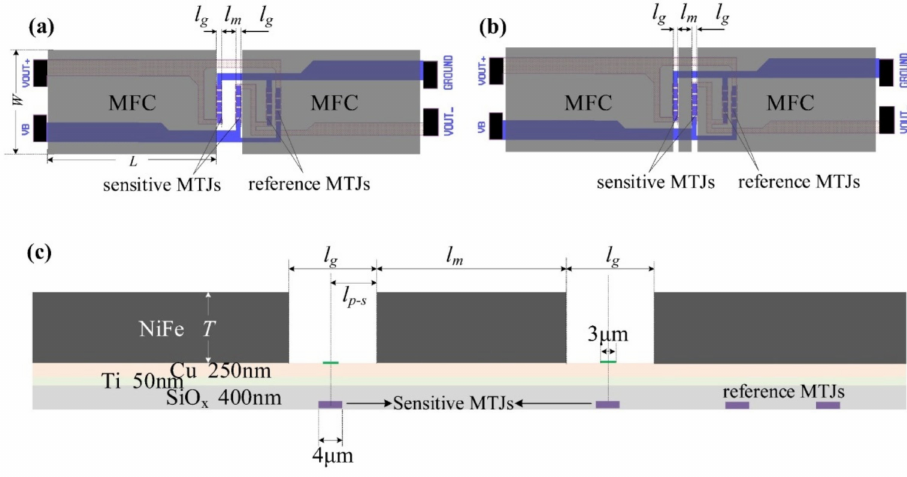
Figure 1. Layout of the sensor containing ( a ) single-gap magnetic flux concentrators (MFCs), ( b ) double-gap MFCs, and ( c ) cross-section layout highlighting the double gap